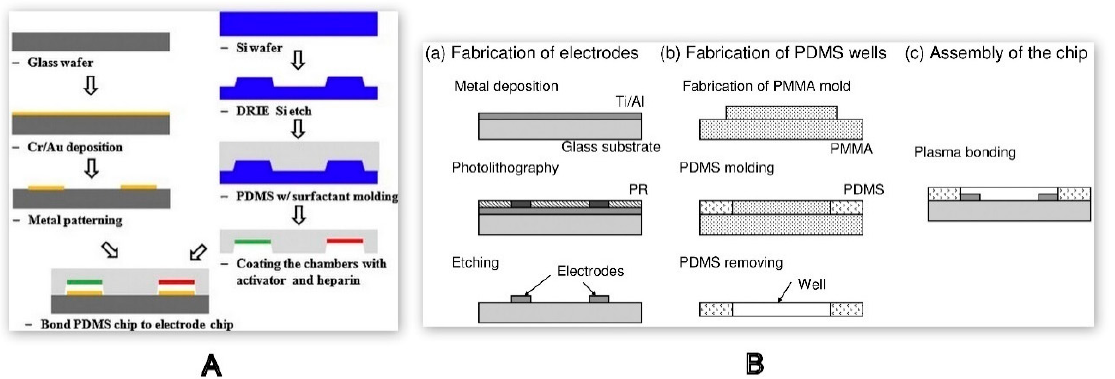
Figure 12. ( A ) Illustration of the fabrication process of a microfluidic chip using a glass wafer for electrode deposition and a silicon wafer for PDMS microchannel formation [22]. ( B ) Fabrication process for an electrochemical impedance-based blood coagulation device using photolithography. Taken with permission from [42].